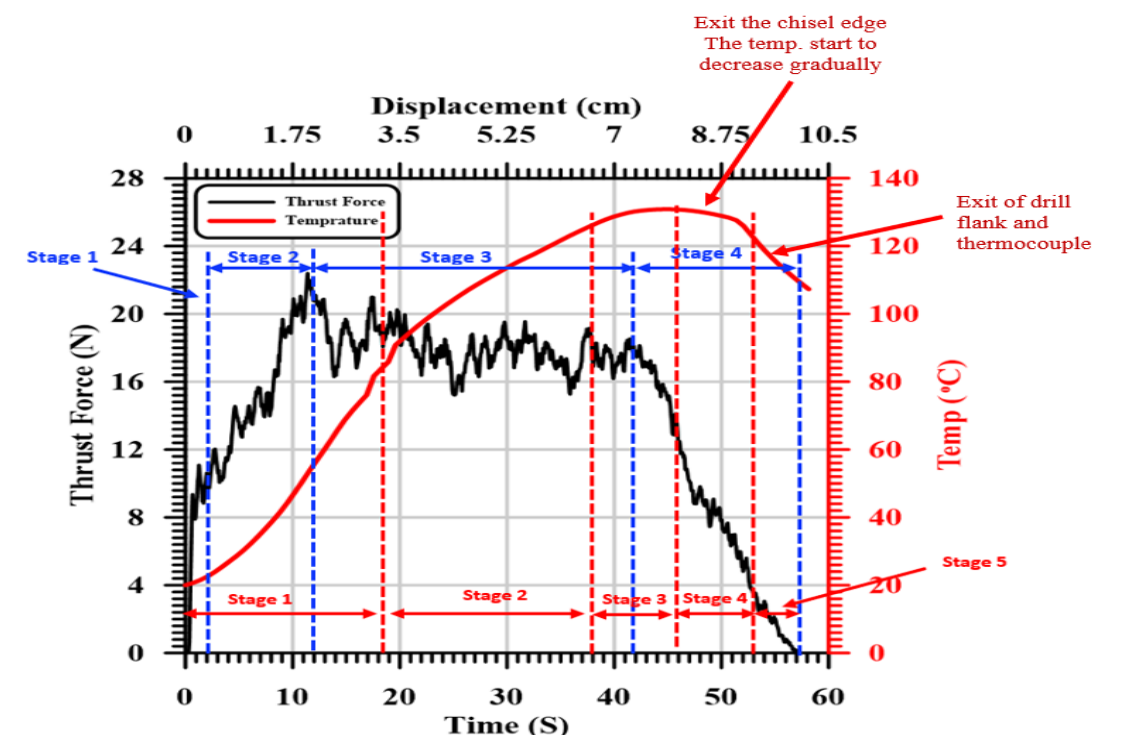
Figure 4. Evolution of thrust force and the induced temperature vs. time (displacement) in drilling GFRP with 7.7 mm thickness at 400 r/min and 0.025